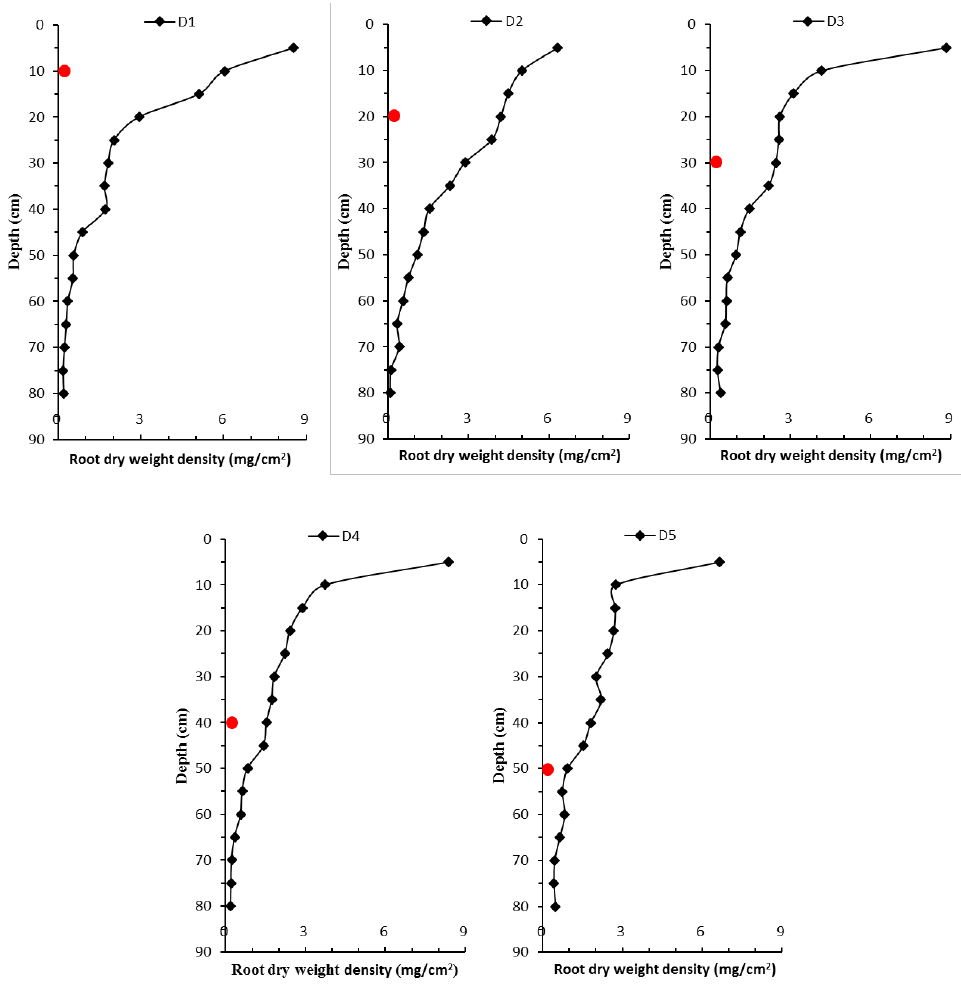
Figure 9. Changes in the root dry weight density with soil depth for the five treatments.